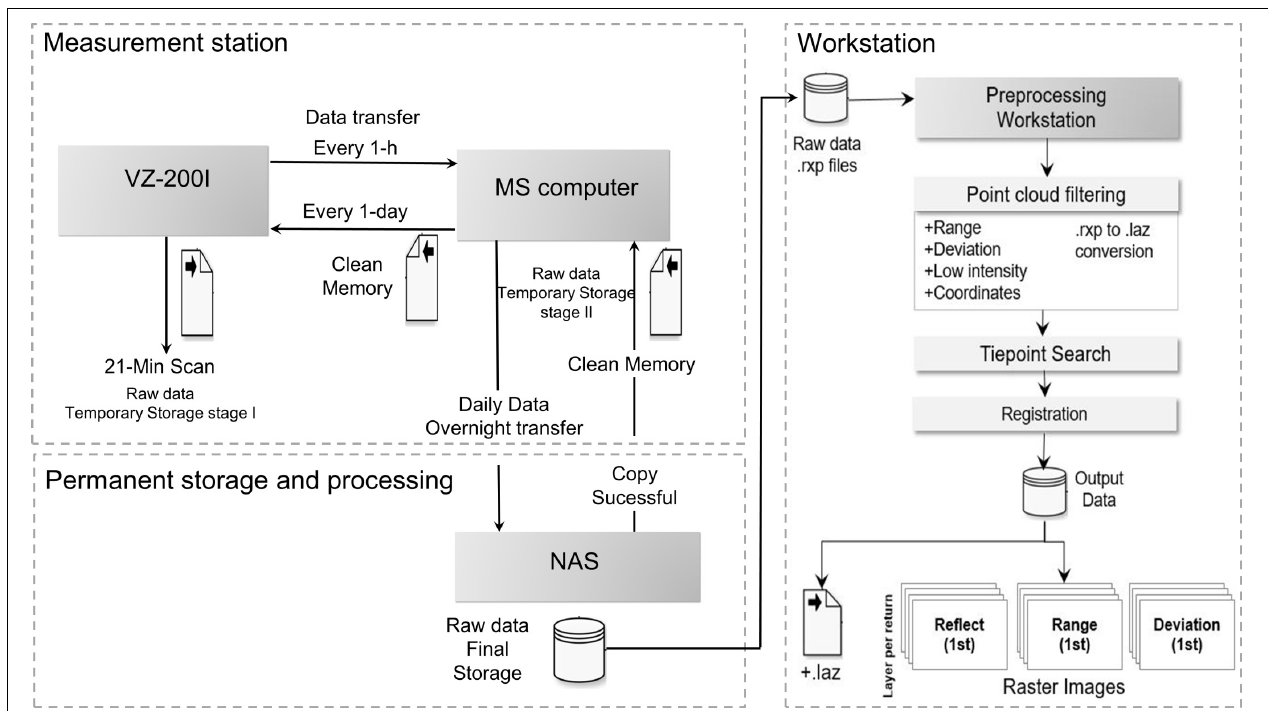
FIGURE 2 | TLS measurement station data acquisition and pre-processing framework. Each block defined with a dashed line represents an independent unit that can be physically separated from the others.